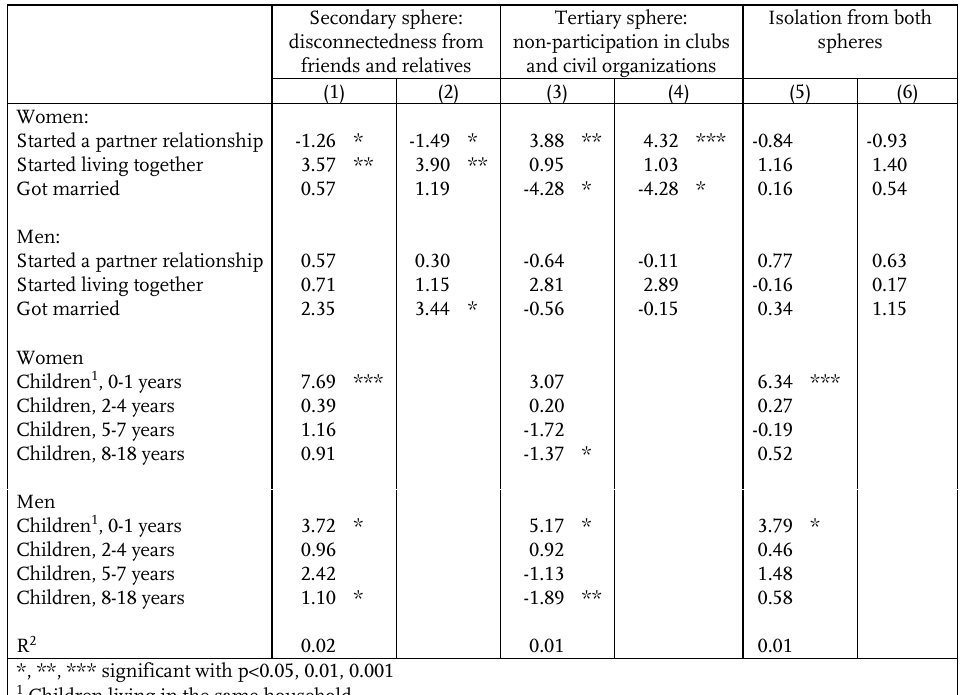
Table 2 : Effects of partner relationships and children on social isolation (linear-probability models with fixed effects, percentage